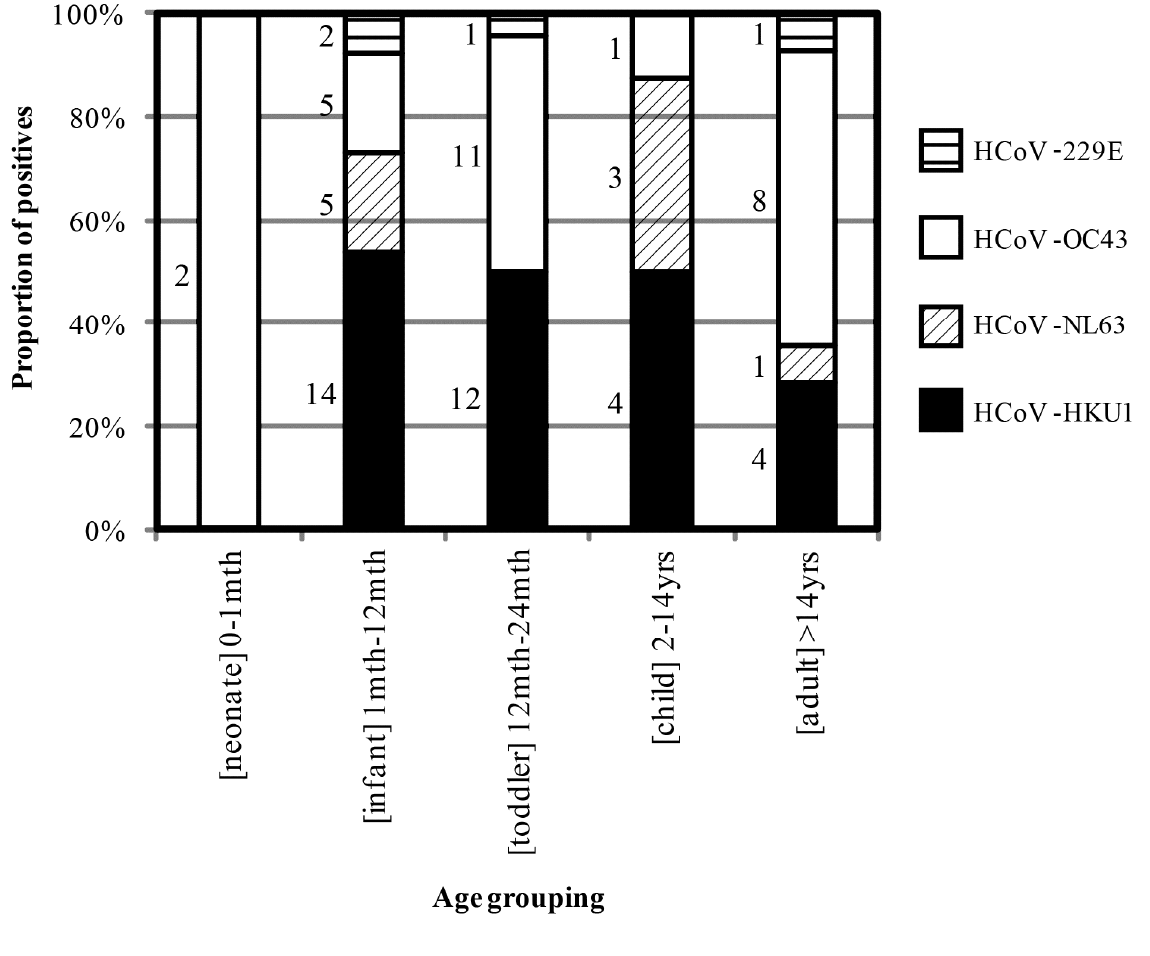
Figure 2. Comparison of the proportion of each HCoV detected in each age group. The number of HCoV detections is shown to the left of each